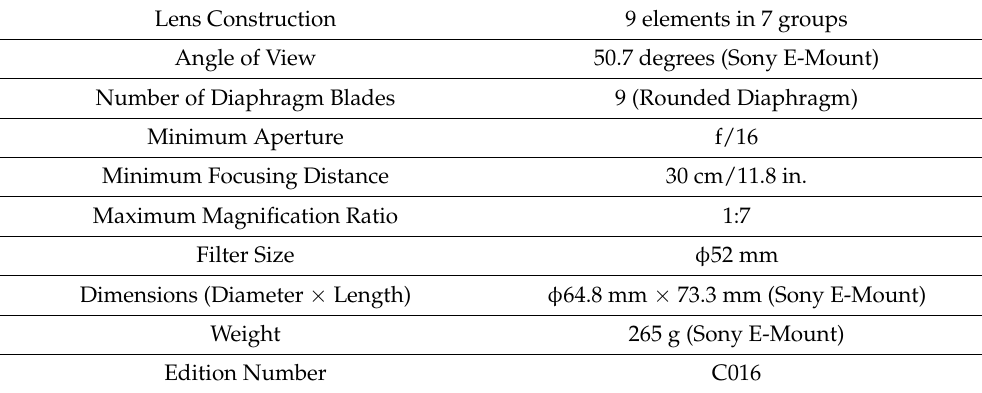
Table 2. Sigma Lens Specifications.